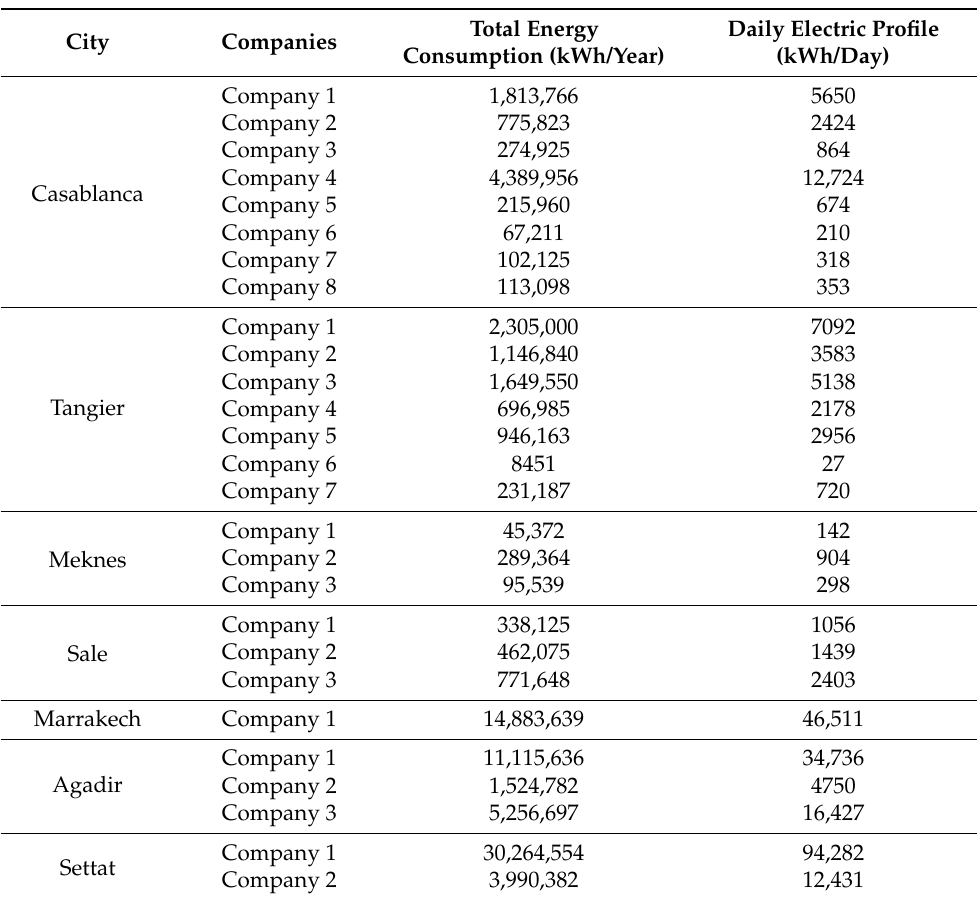
Table 1. Survey summary on electric